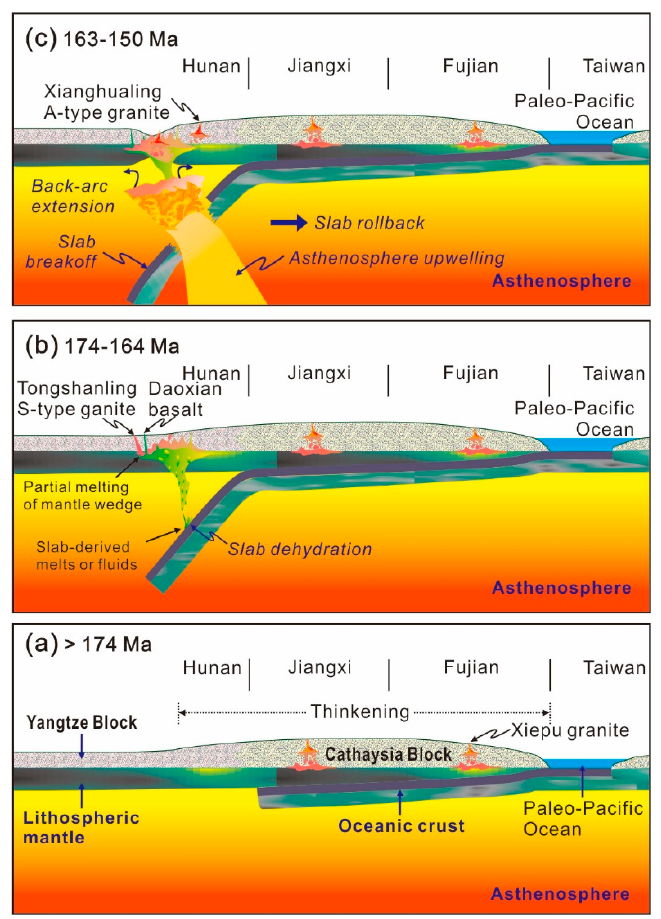
Figure 14. Schematic illustrations showing the generation of the late Jurassic A-type granites in South China. ( a ) Low angle subduction before ~174 Ma, forming the middle Jurassic S-type granites such as the Xiepu granite; ( b ) High-angle subduction during 174 to 164 Ma, forming S-type granites and basalt such as the Tongshanling S-type granite and the Daoxian basalt; ( c ) During the late Jurassic Era, slab rollback and slab breakoff formed the A-type granite such as the Xianghualing granite.